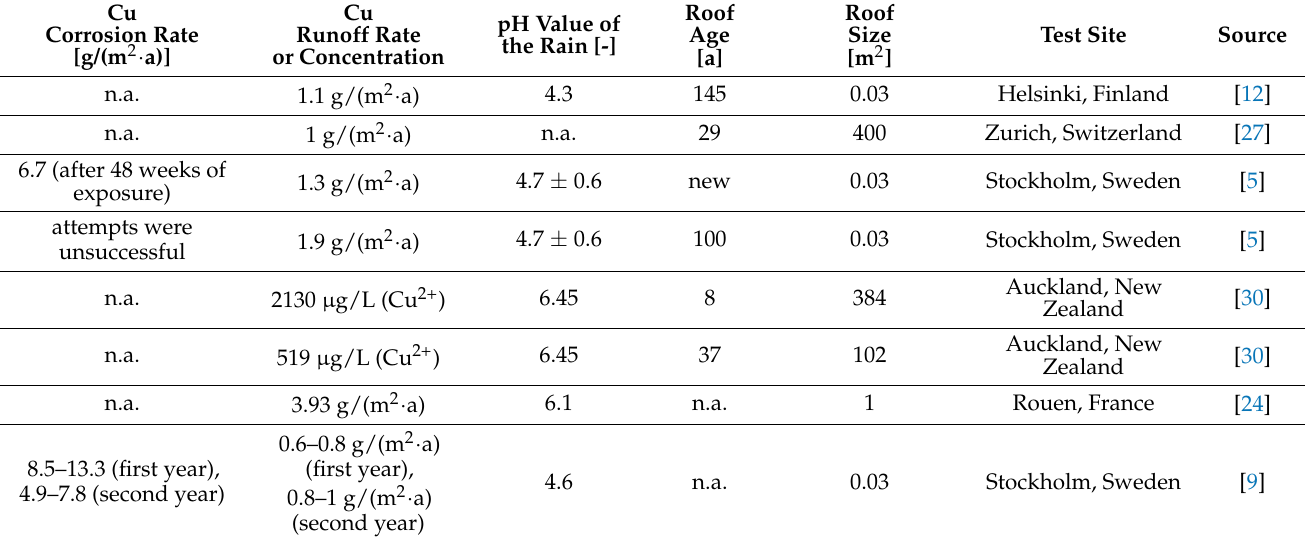
Table 2. Overview of corrosion and runoff rates (respective concentrations in runoff) from Cu roofs under different test conditions, see respective